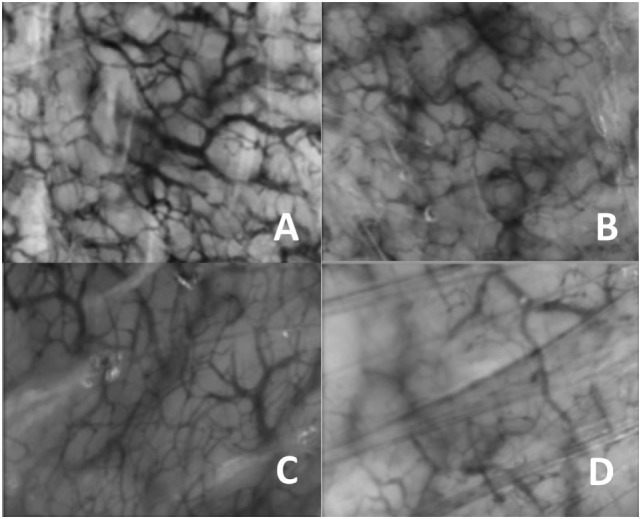
Typical image of the microcirculation. (A) Day 1 control group, (B) day 14 control group, (C) day 1 high PCO2 target group, and (D) day 14 high PCO2 target group.